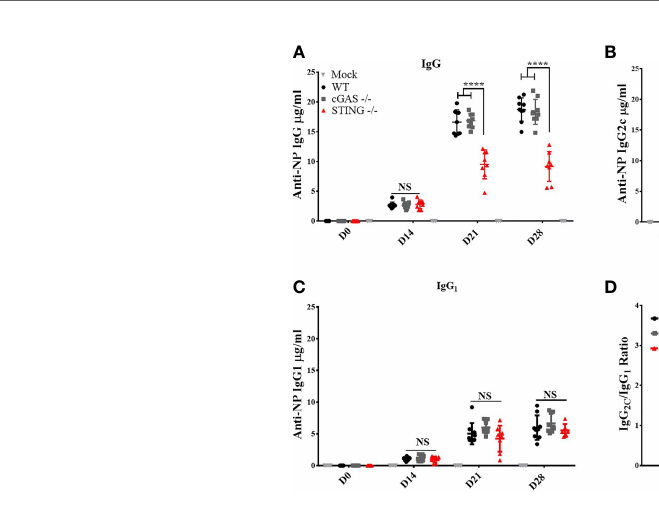
FIGURE 1 | STING is required for DNA vaccine induction of antigen-speci fi c Th1 associated IgG 2C antibody responses. Wild type (WT), cGAS -/- and STING -/- mice were IM/EP vaccinated with a DNA vaccine (pNP) expressing in fl uenza nucleoprotein (pNP). Sera were collected prior to vaccination (D0), and at 14 (D14), 21 (D21), and 28 days post-vaccination (D28). The concentration of anti-NP (A) IgG, (B) IgG 2C and (C) IgG 1 antibody responses was measured by ELISA. Each ELISA plate used goat anti-mouse IgG and known concentrations of mouse IgG, IgG 2C , or IgG 1 to create a standard curve to back calculate antibody titers ( m g/ml). (D) The Th1:Th2 ratio was calculated as IgG 2C :IgG 1 , a higher ratio is indicative of a Th1 response. Three independent experiments consisting of 3-9 mice were performed consisting of 3-9; representative data are the average ±SD 3-9 mice/genotype. At each timepoint a one-way ANOVA was used. ****p < 0.0001 and NS, not signi fi